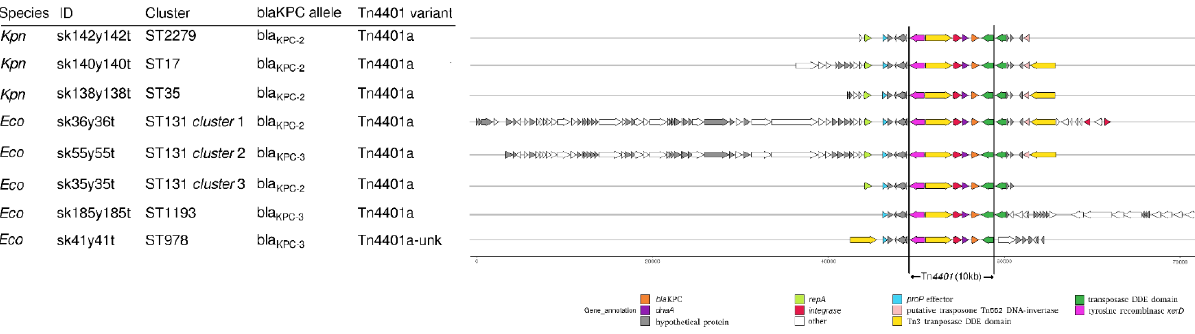
Figure 4. Arrow plot of the different bla KPC gene contigs aligned on the Tn4401 transposon (shown inside the vertical lines). The plot includes one representative strain for each Escherichia coli cluster and one for each Klebsiella pneumoniae ST.